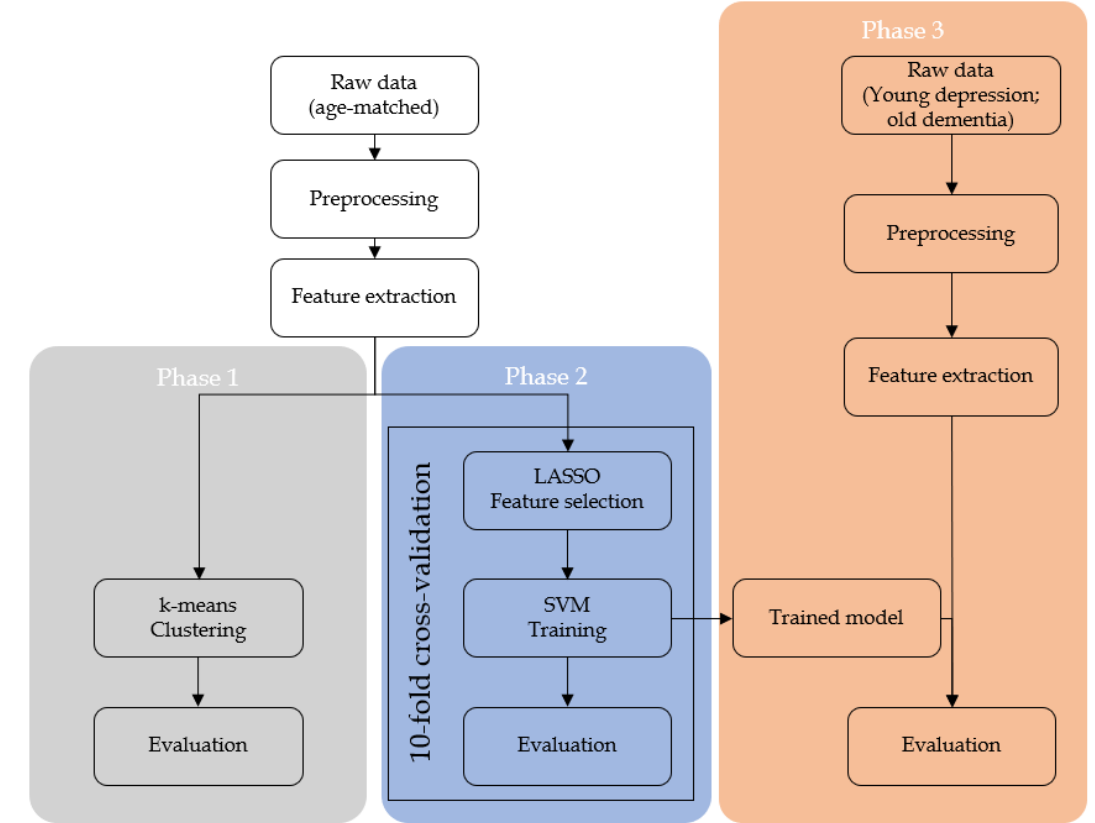
Figure 3. Flowchart of supervised machine learning procedure. The first and second phase used age-matched symptomatic depression and dementia subjects. The first phase consists of unsupervised machine learning clustering while the second phase consists of conventional training and